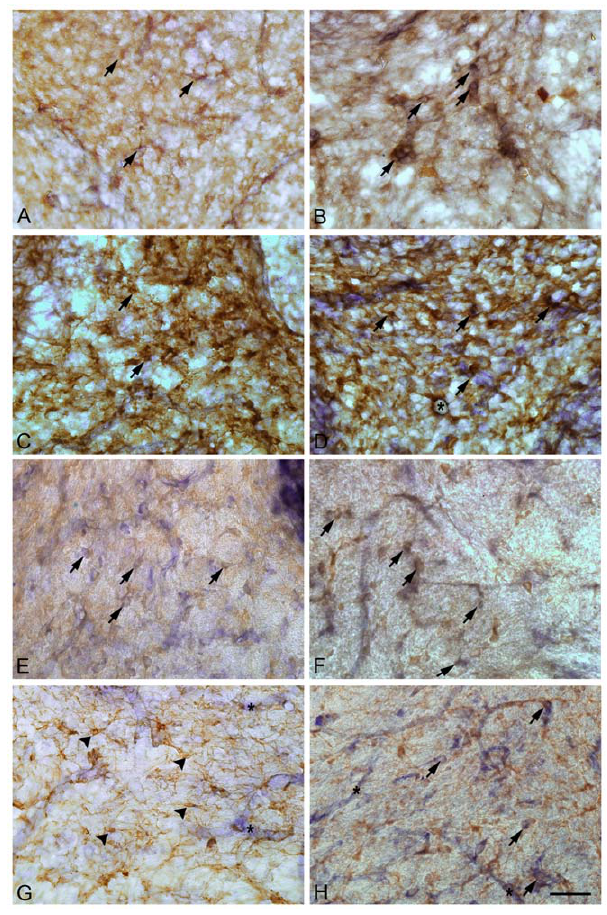
Figure 4. Double labeling with NADPH-d histochemistry (dark- blue) and microglia or astroglia immunoidentification (brown) in the vermis region of the cerebellar WM (0.5 mm mediolat- eral distance), during development. A–D - P9; E-H - P23. A, C, E and G (SHAM); B, D, F and H (HI); A–B and E–F – double labeled with anti- ED1 antibody; C–D and G–H – double labeled with anti-GFAP antibody. In both groups at P9, we can observe small, rounded NADPH-d + /ED1 + cells (A and B) or NADPH-d + /GFAP + cells (C and D), as indicated by arrows. In D, observe a blood vessel, transversally cut, which presents NADPH-d staining, surrounded by GFAP + astrocytic endfeet (asterisk). At P23, observe small rounded NADPH-d + /ED1 + cells in both groups, as indicated by arrows. HI animals display NADPH-d + /GFAP + cells with typical reactive astrocyte morphology (arrows). SHAM animals do not present NADPH-d + /GFAP + cells resembling reactive astrocytes. Arrow- heads point to typical GFAP + astrocytes, with no NADPH-d labeling. Notice the presence of NADPH-d + blood vessels (asterisks in G and H) that are surrounded by GFAP + astrocytic processes in HI animals (H) but not in SHAM animals (G). Calibration bar: 50 m